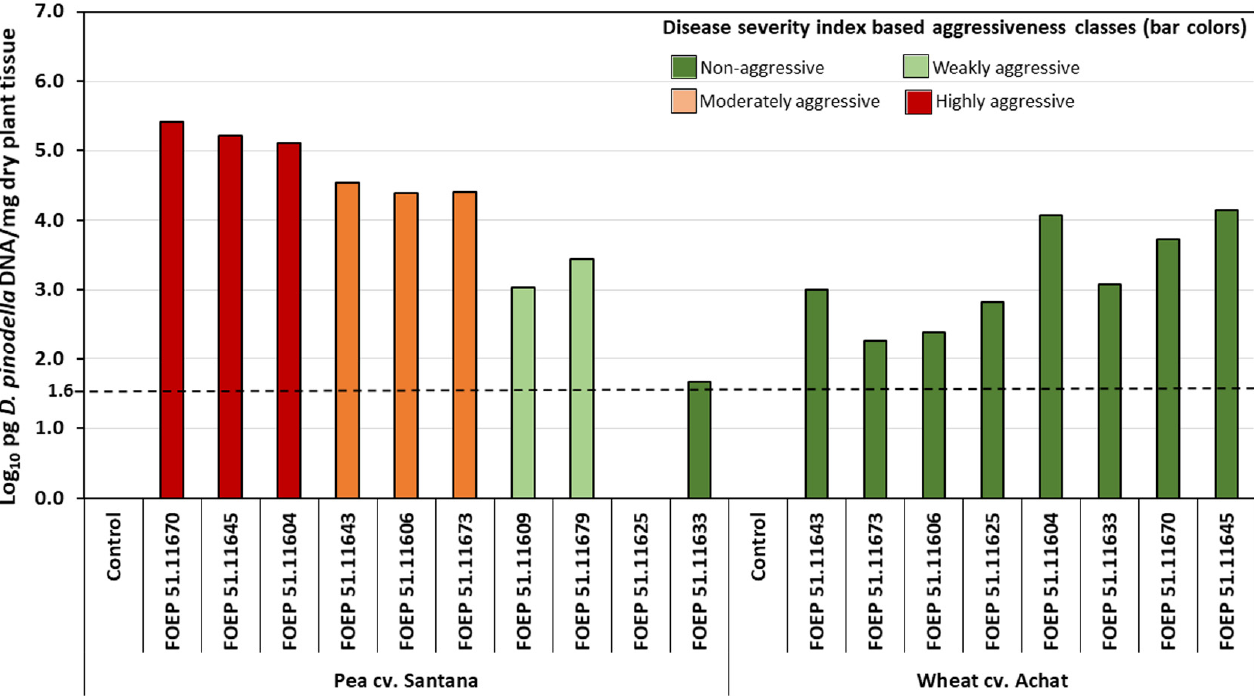
Figure 3. Mean DNA concentrations of D. pinodella isolates in greenhouse inoculated pea and wheat roots. The dashed horizontal line shows the assay limit of detection (LOD) which is the minimum amount of the pathogen DNA detectable for the lowest pathogen concentration with positive reads for all repetitions at the ≤ 35 cycle threshold. Different bar colors correspond to the isolate disease severity index (DSI) classes, where DSI = 0– 15 non-aggressive; DSI = 16-30 weakly aggressive; DSI = 31–70 moderately aggressive; DSI = 71–100 highly aggressive. The concentrations are means of two technical replicates expressed on logarithmic scale per milligram (mg) freeze dried root tissue.